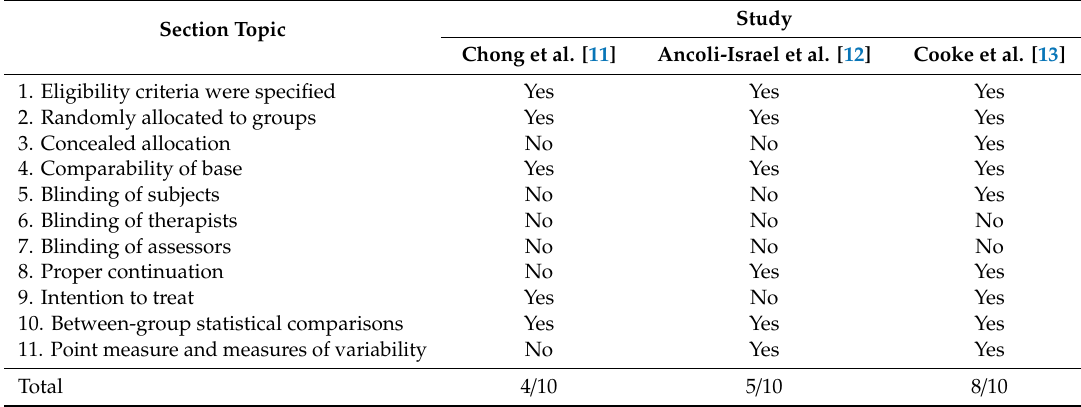
Table 2. PEDro Score for Methodological Quality Assessment of 3